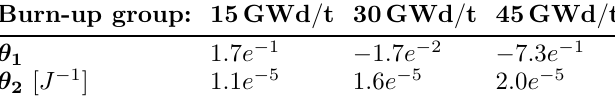
Table 4. Estimated calibration parameters of Hgap